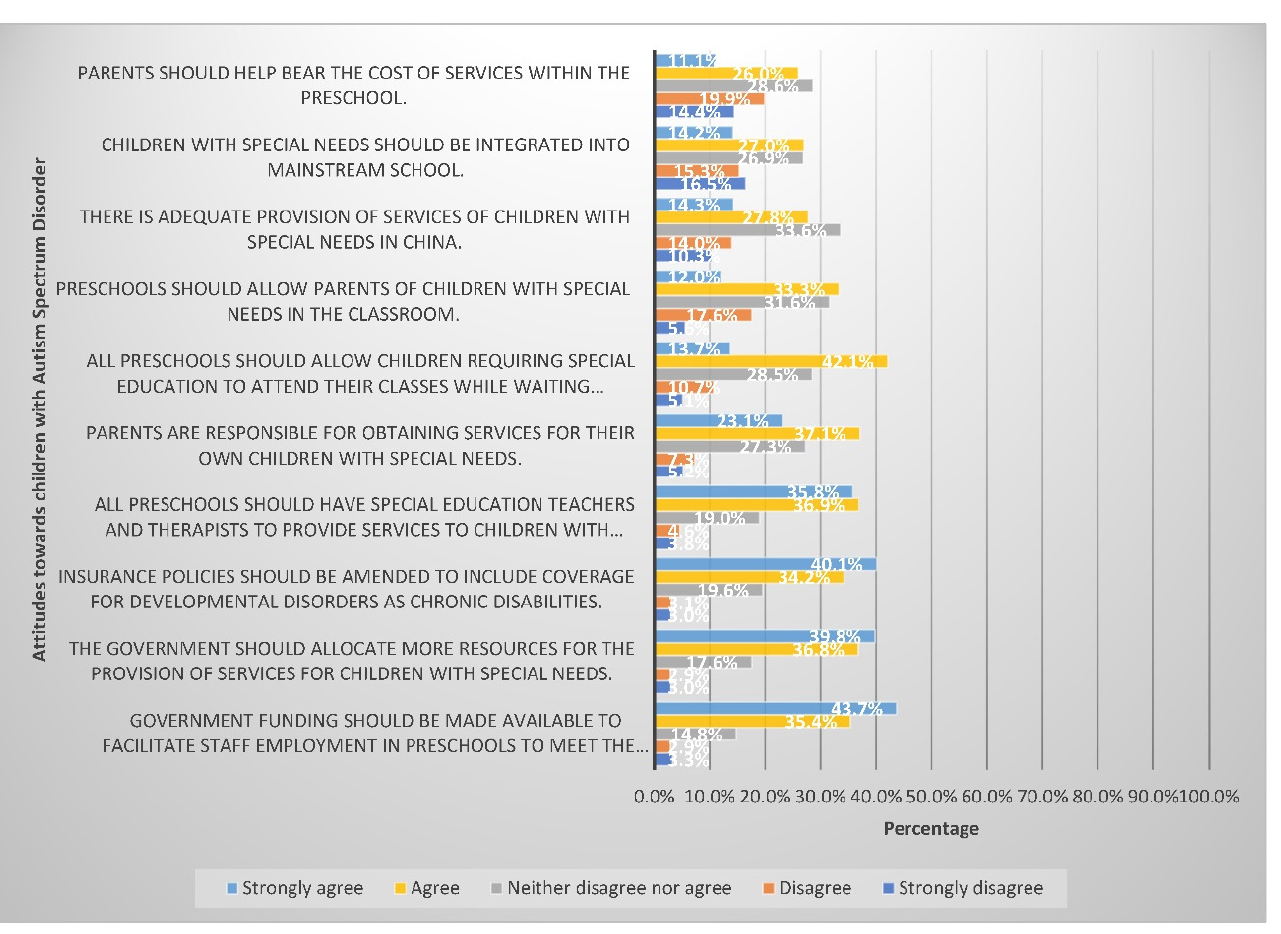
Figure 2. Attitudes towards the care and education of, and advocacy for, children with autism.